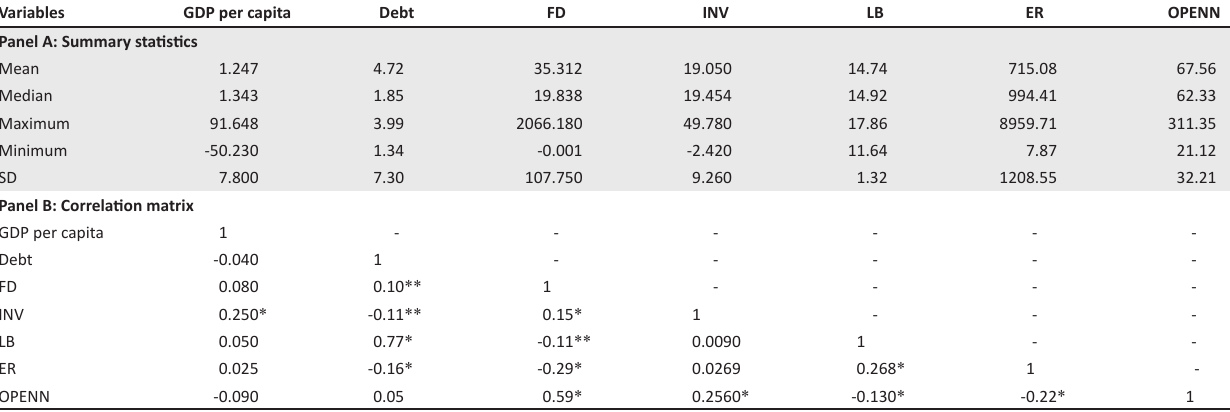
Panel B: Correlation matrix